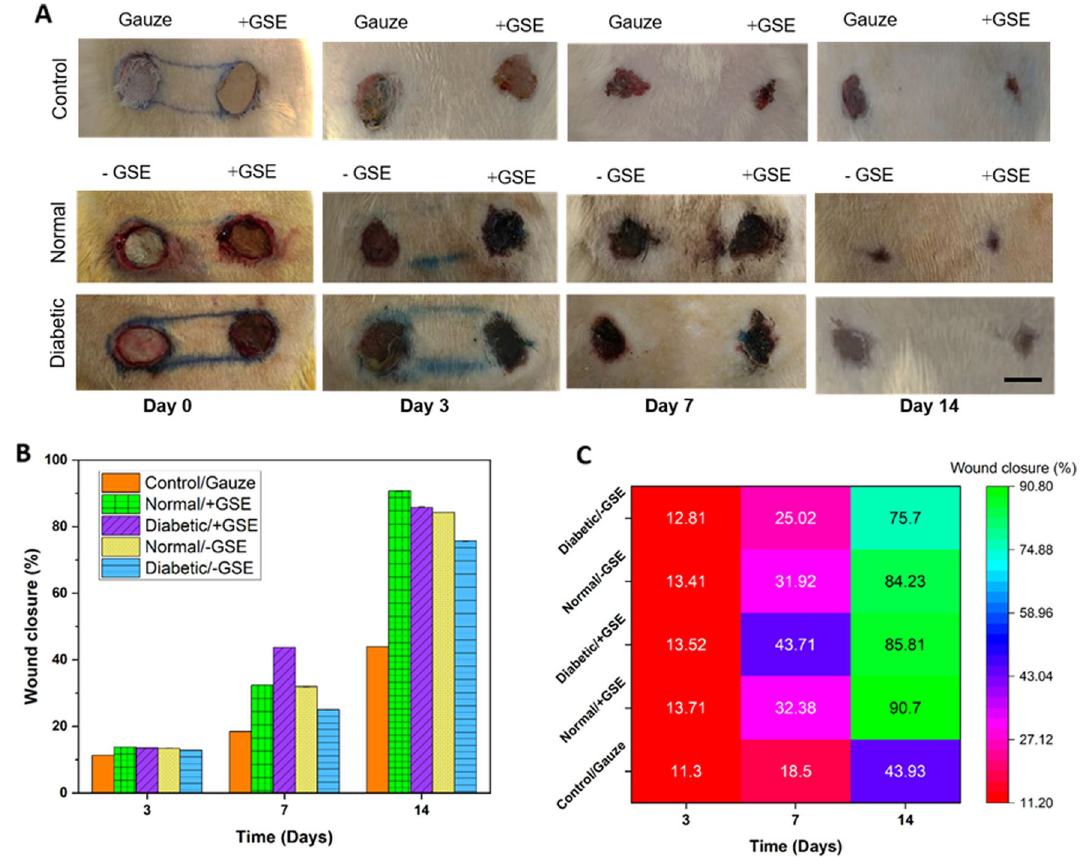
Figure 7. Macroscopic evaluation of wound healing in normal and diabetic rats. ( A ) Models on days 0, 3, 7, and 14 following surgery, demonstrating the wound’s gradual healing over time. Scale bar represents 10 mm. ( B ) Wound closure percentage and heatmap graph in diabetic and normal groups with and without extract during days 3, 7 and 14 of the repair processes. ( C ) GSE represents treatment without grape seed extract; + GSE represents treatment with seed extract. Scale bar represents 10